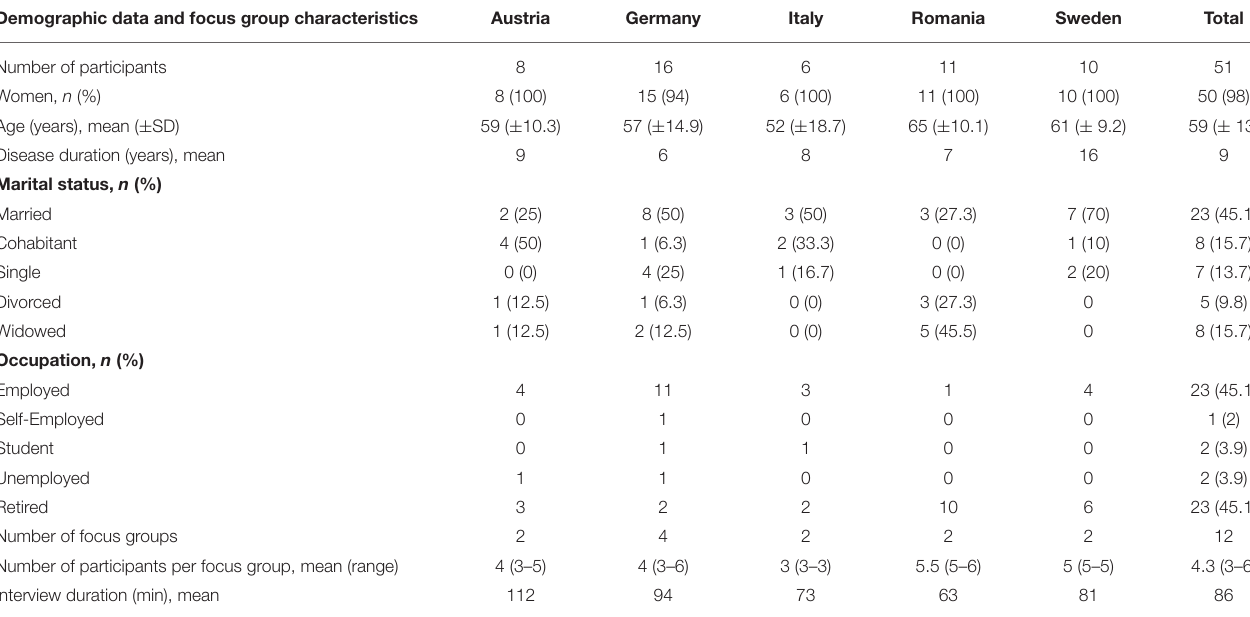
TABLE 1 | Demographic data of the participants and characteristics of the focus groups per country. Demographic data and focus group